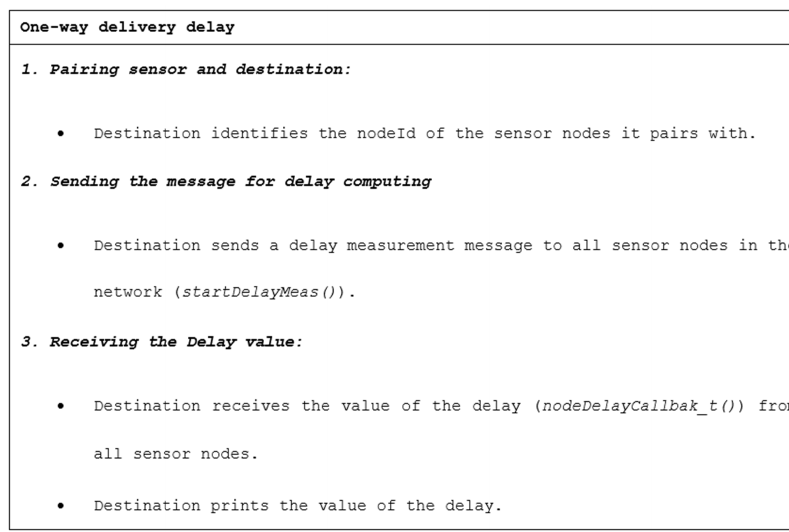
Information 2022 , 13 , x FOR PEER REVIEW Figure 7. UML modeling for calculating one-way delivery delay. Figure 7. UML modeling for calculating one-way delivery delay.